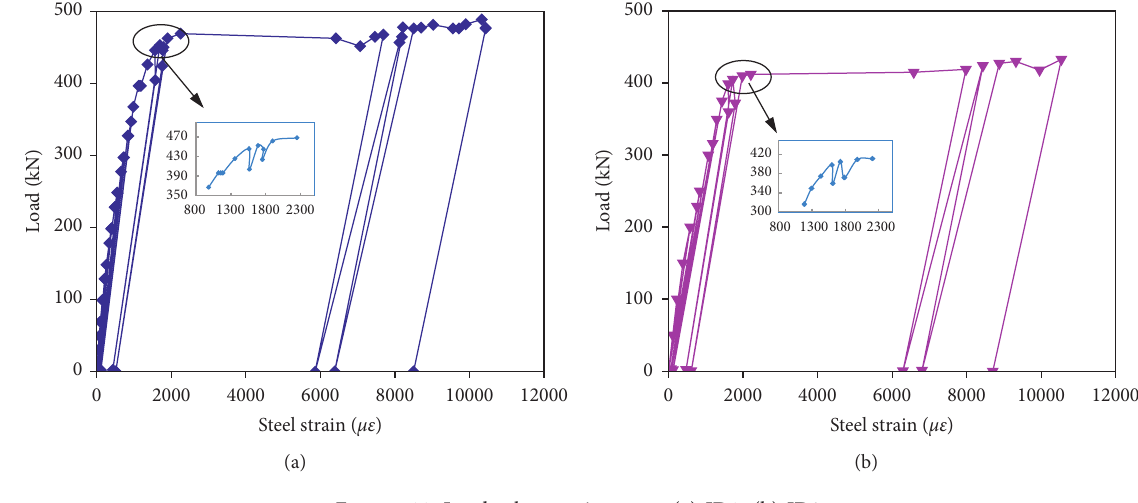
Figure 11: Load-rebar strain curve: (a) JD1; (b) JD2.